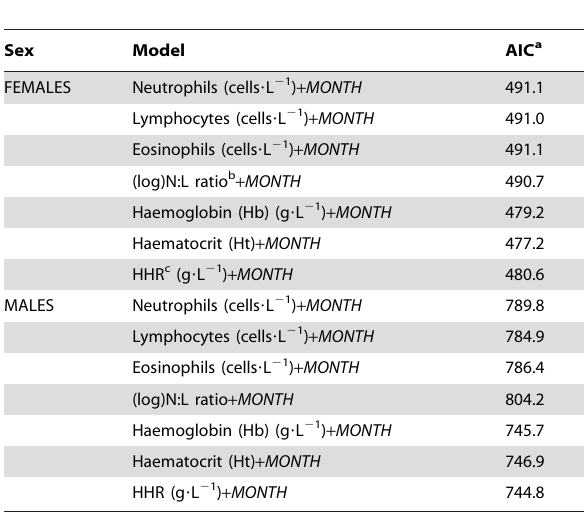
Table 4. Information-theoretic (AIC) parameters for blood cell measurements and time of year ( MONTH ) as explanatory models for Mass-Size Residuals (g).